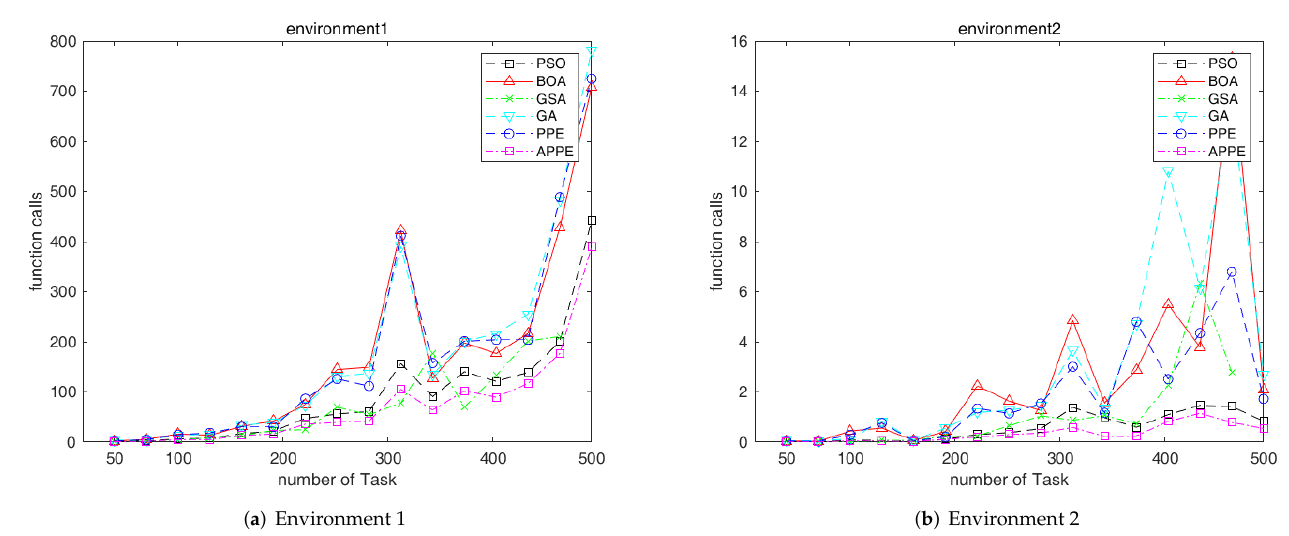
Figure 2. Performance comparison of algorithms in heterogeneous environment